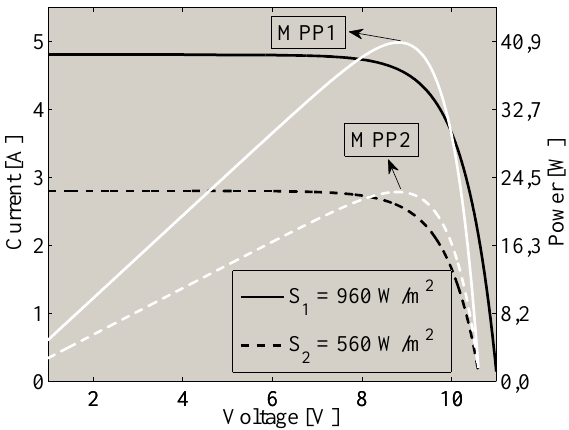
Figure 3. I-V (black) and P-V (white) curves of a BP-585U PV